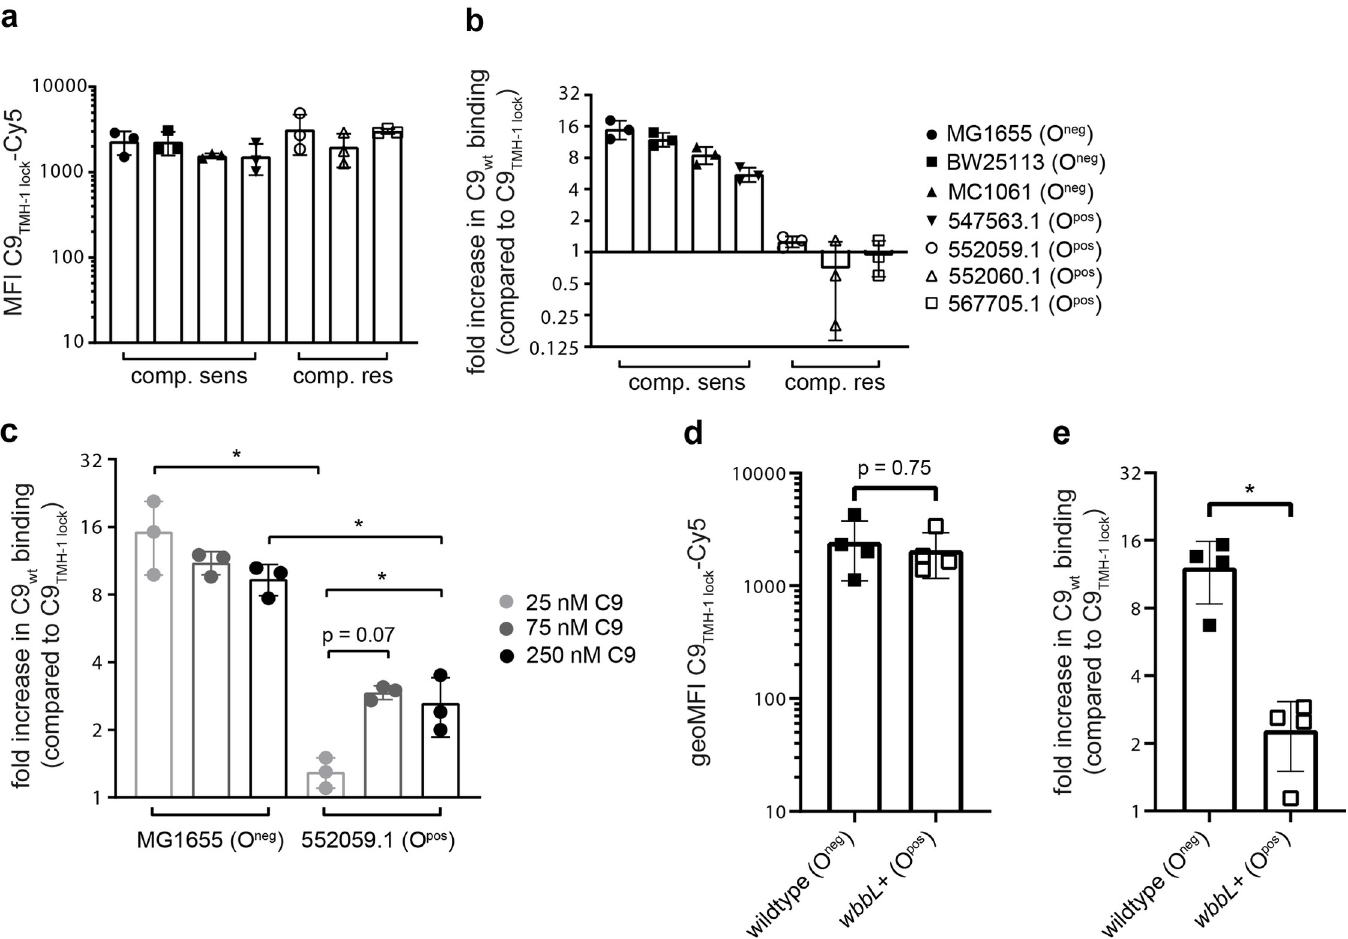
Fig 6. Polymerization of C9 is impaired on complement-resistant E . coli that express LPS O-Ag. a-c) Complement-resistant (552059.1, 552060.1 and 567705.1) and complement-sensitive (MG1655, BW25113, MC1061 and 547563.1) E . coli strains were incubated in 3% C9-depleted serum supplemented with a physiological concentration (= 25 nM) of Cy5-labelled C9 wt or C9 TMH-1 lock for 30 minutes to measure C9 binding by flow cytometry. a) Binding of Cy5-labelled C9 TMH-1 lock to bacteria. b) The relative increase in C9 wt binding compared to bacteria labelled with C9 TMH-1 lock was calculated as indication for C9 polymerization. c) The relative increase in C9 wt binding compared to bacteria labelled with C9 TMH-1 lock was compared for complement-sensitive MG1655 and complement-resistant 552059.1 at different C9 concentrations. d-e) CGSC7740 wildtype and wbbL + were incubated in 3% C9-depleted serum similarly as E . coli strains in a-c). d) Binding of Cy5-labelled C9 TMH-1 lock to bacteria. e) The relative increase in C9 wt binding compared to bacteria labelled with C9 TMH-1 lock was calculated as indication for C9 polymerization. Flow cytometry data are represented by MFI values of the bacterial population. Data represent individual values with mean +/- SD of three (a, b and c) or four (d and e) independent experiments. Statistical analysis was done on log-transformed data ( 2 log for c and e, 10 log for d) using a paired one-way ANOVA with Tukey’s multiple comparisons’ test (a-c) or a paired t-test (d and e). Significance was shown as � p � 0.05.